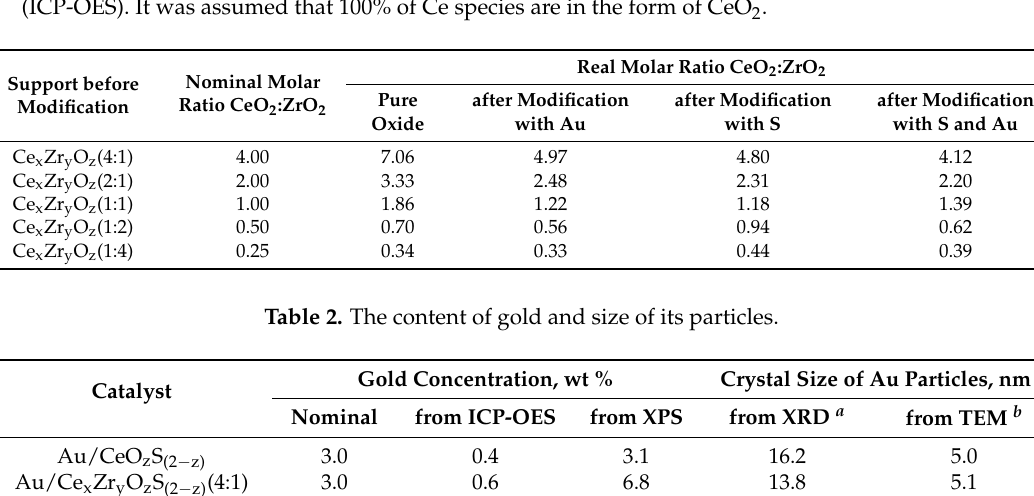
Table 1. The comparison between real and nominal molar ratio CeO 2 :ZrO 2 in prepared oxides.